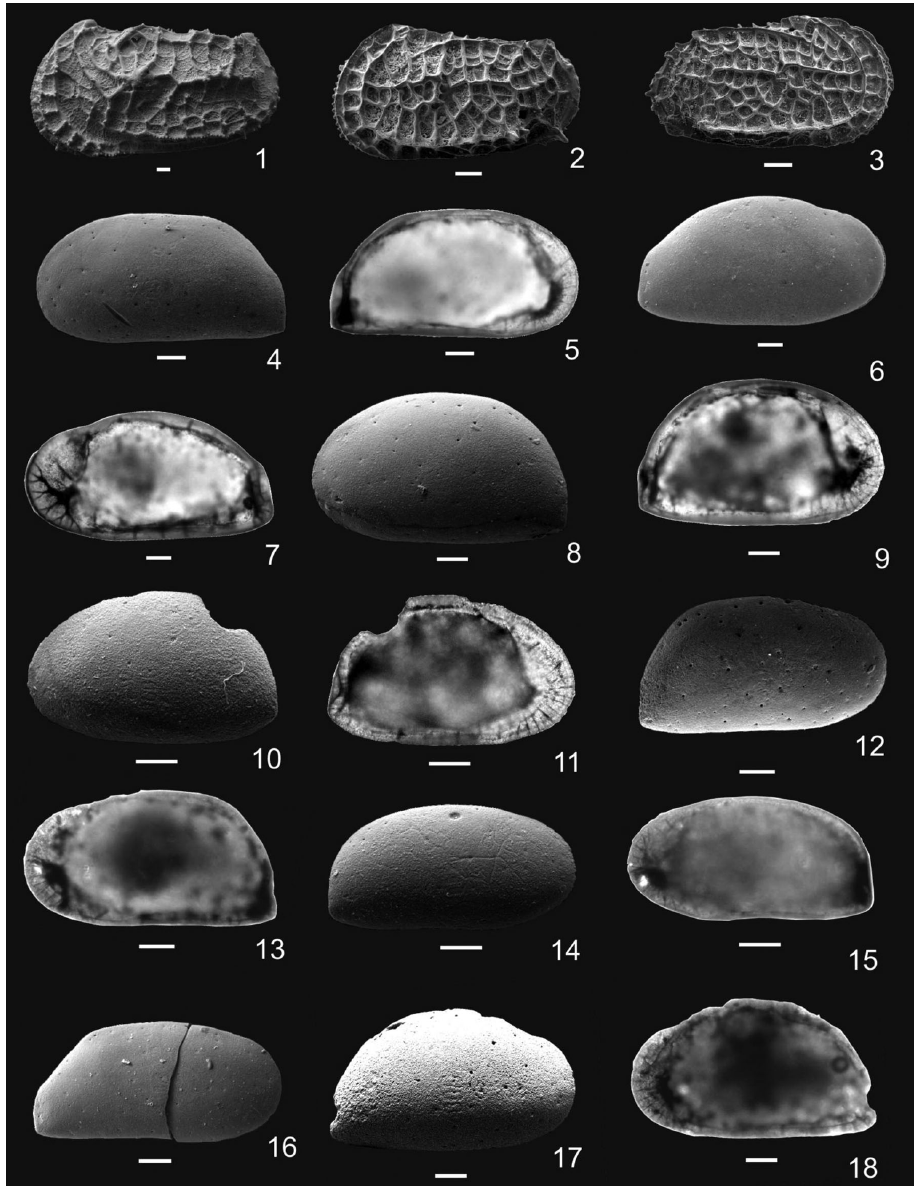
Fig. 4 – 1. Dutoitella sp. 2, LV, 119-744A-13H-5W-6. 2. Bradleya johnsoni Benson, LV, 119-744A-16H-2W-4; 3. Bradleya thomasi Steineck and Yozzo RV, 119-744A-8H-2W-90; 4-5. Krithe sp. 1. 4. LV, 119-744A-16H-5W-4. 5. Same specimen in optical microscopy; 6-7. Krithe sp. 2, 6. RV, 119-744A-6H-2W-6. 7. Same specimen in optical microscopy; 8-9. Krithe sp. 3, 8, LV, 119-744A-18h-3W-6. 9. Same specimen in optical microscopy. 10-11. Krithe sp. 4. 10. LV, 119-744A-16H-2W-4. 11. Same specimen in optical microscopy. 12-13. Krithe sp. 5. 12. LV, 119-744A-16H-1W-4. 13. Same specimen in optical microscopy. 14-15. Krithe sp. 6. 14. RV, 119-744A-19H-2W-5. 15. Same specimen in optical microscopy. 16. Krithe sp. 7, RV, 119-744A-18H-3W-6. 17-18. Krithe sp. 8. 17. RV, 119-744A-18H-3W-6. 18. Same specimen in optical microscopy. (Scale 100 μ